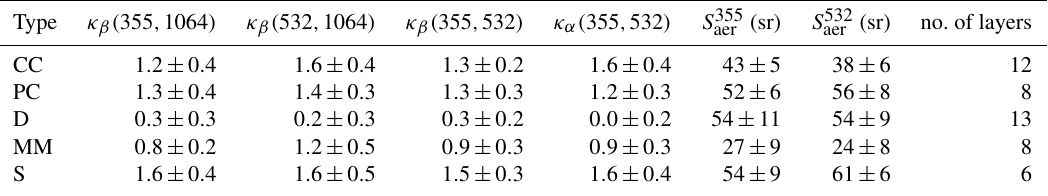
Figure 7. Bar plots show the median (horizontal line), 25–75 percentile (box), and 5–95 percentile (whisker) of the four classifying param- eters: δ 532 aer , κ β ( 355 , 1064 ) , S 532 aer , and S 532 aer /S 355 aer . CC stands for clean continental, D stands for dust, MD stands for mixed dust, MM stands for mixed marine, PD stands for polluted dust, PC stands for polluted continental, S stands for smoke, and V stands for volcanic particles. Table 5. Testing dataset: mean type-dependent intensive properties along with the standard